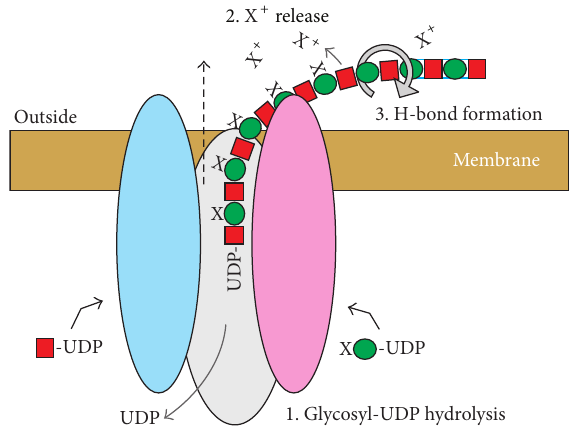
Figure 8: Three energy sources may drive the HAS-mediated translocation of HA-UDP. The diagram illustrates three sources of energy (numbers 1–3) that could contribute to an overall favorable free energy change to drive translocation (dashed black arrow), equivalent to ∼ 1 ATP per disaccharide, as discussed in the text. 1. Two HA-UDP bonds are hydrolyzed to make two glycoside bonds per disaccharide. 2. Energy can be captured by extracellular release of a cation (X + ; bound to the intracellular GlcUA-UDP substrate and incorporated into HA by HAS) as the GlcUA is released from HAS and any associated restraints on the –CO 2 X group by the translocation process. Subsequent reactions in the extracellular environment (e.g., ion-pair association, dissociation, or exchange) and the coupling of a released ion, such as K + , to a cellular elec- trochemicalgradient(potential)wouldprovidefavorableenergetics. 3. Up to four H-bonds (blue lines between sugars at far right) could be formed as each new GlcNAc-GlcUA disaccharide (red squares and green circles, resp.) is released to the exterior, free of constraints imposed by being bound to HAS. For example, two H- bonds between the released disaccharide GlcNAc and GlcUA and twoH-bondsbetweentheGlcUAinthedisaccharidereleasedduring the previous synthetic cycle and the new disaccharide GlcNAc. The gray circular arrow indicates a glycosidic bond that rotates (e.g., so that the N-acetyl and carboxyl group of adjacent sugars are on the same side of the chain) allowing the formation of new